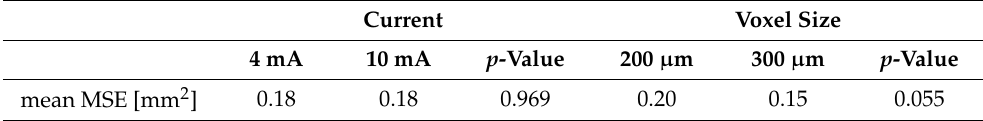
Table 3. Voxel size and current assessment.